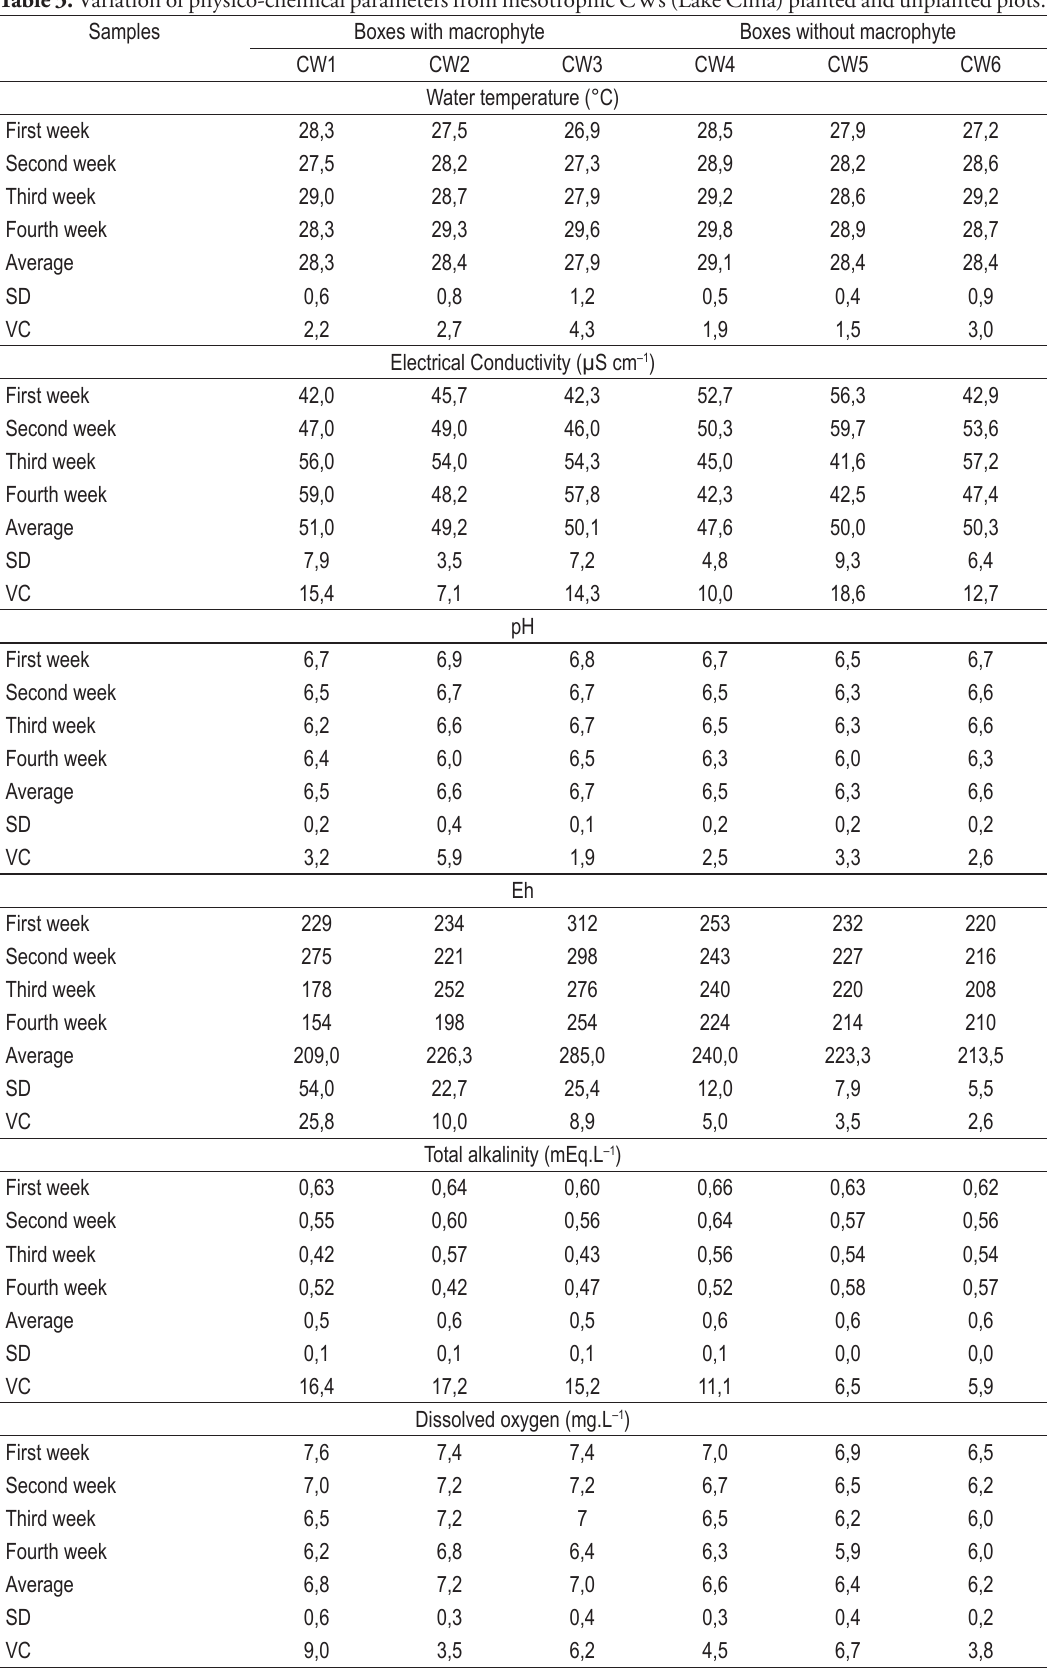
Table 3. Variation of physico-chemical parameters from mesotrophic CWs (Lake Cima) planted and unplanted plots. Samples Boxes with macrophyte Boxes without macrophyte CW1 CW2